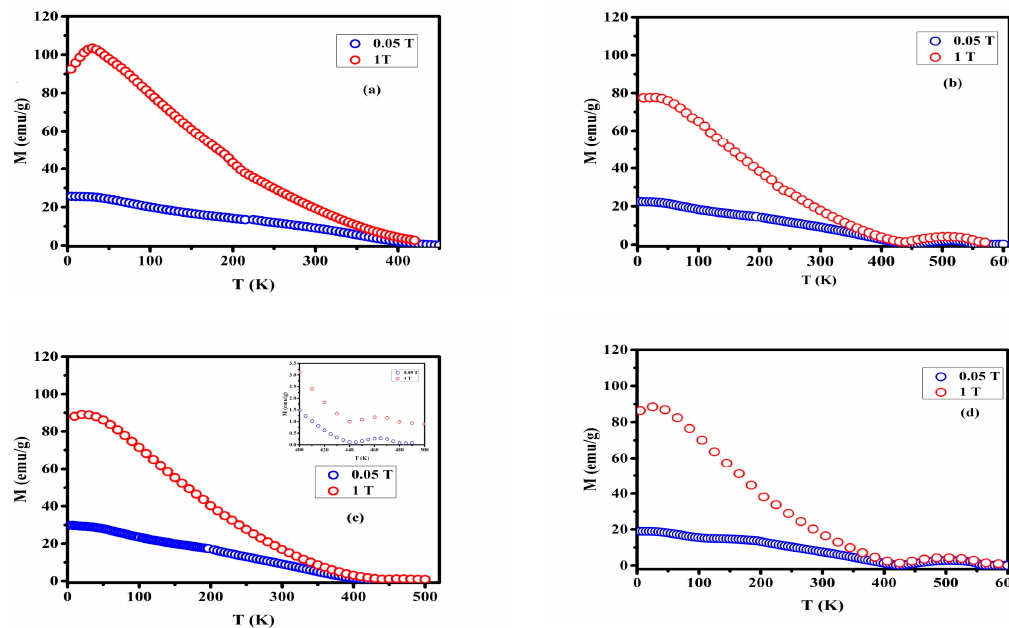
Figure 3. Temperature dependence of the magnetization under 0.05 T (blue) and 1 T (red) for ( a ) Er(Fe 0.8 Mn 0.2 ) 2 ( b ) Er(Fe 0.8 Mn 0.1 Co 0.1 ) 2 ( c ) Er(Fe 0.7 Mn 0.2 Co 0.1 ) 2 and ( d ) Er(Fe 0.7 Mn 0.1 Co 0.2 ) 2 . The inset of